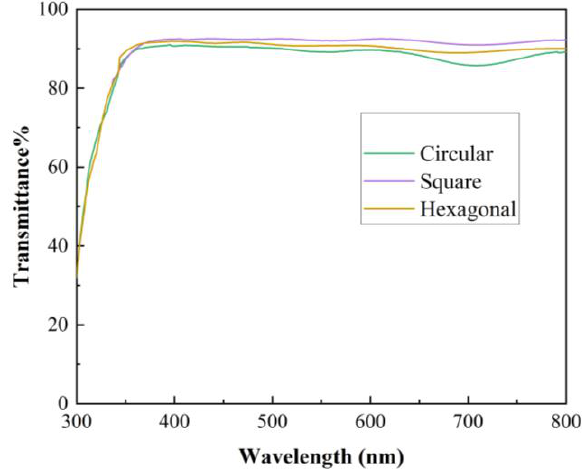
Figure 4. The optical transmittance of the photoresist film MLAs with different shapes and deposited on glass substrates.